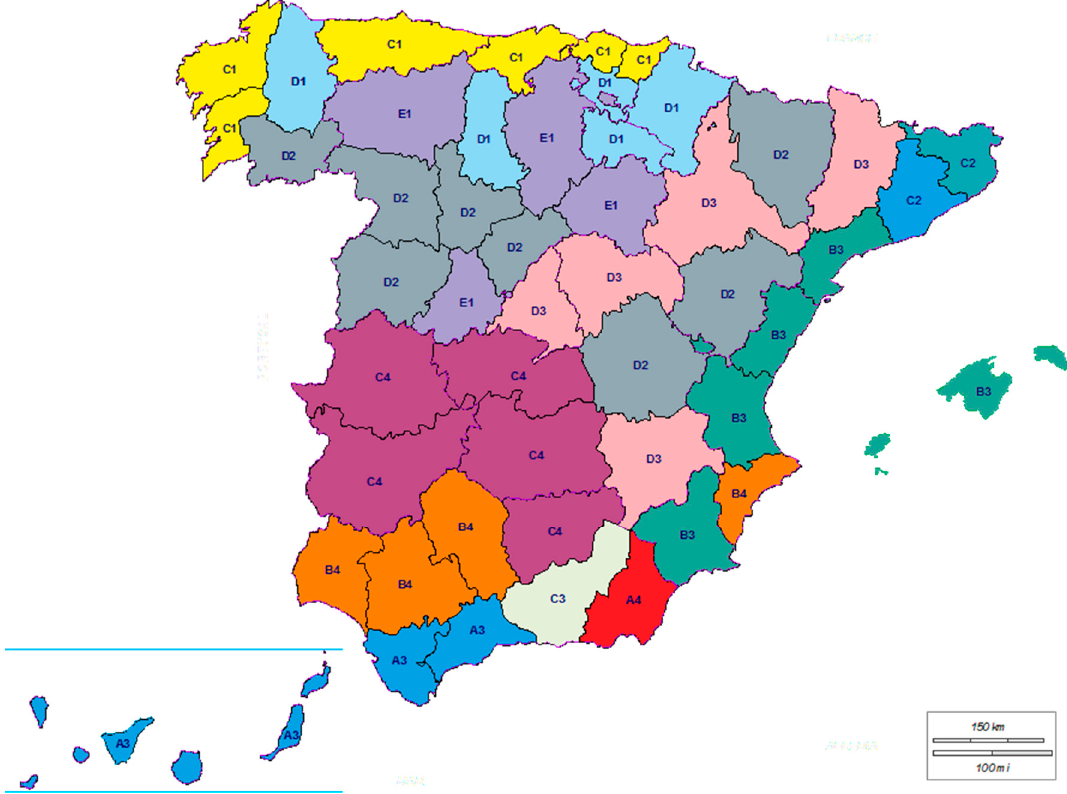
Figure 3. Distribution map of Spanish thermal zones.